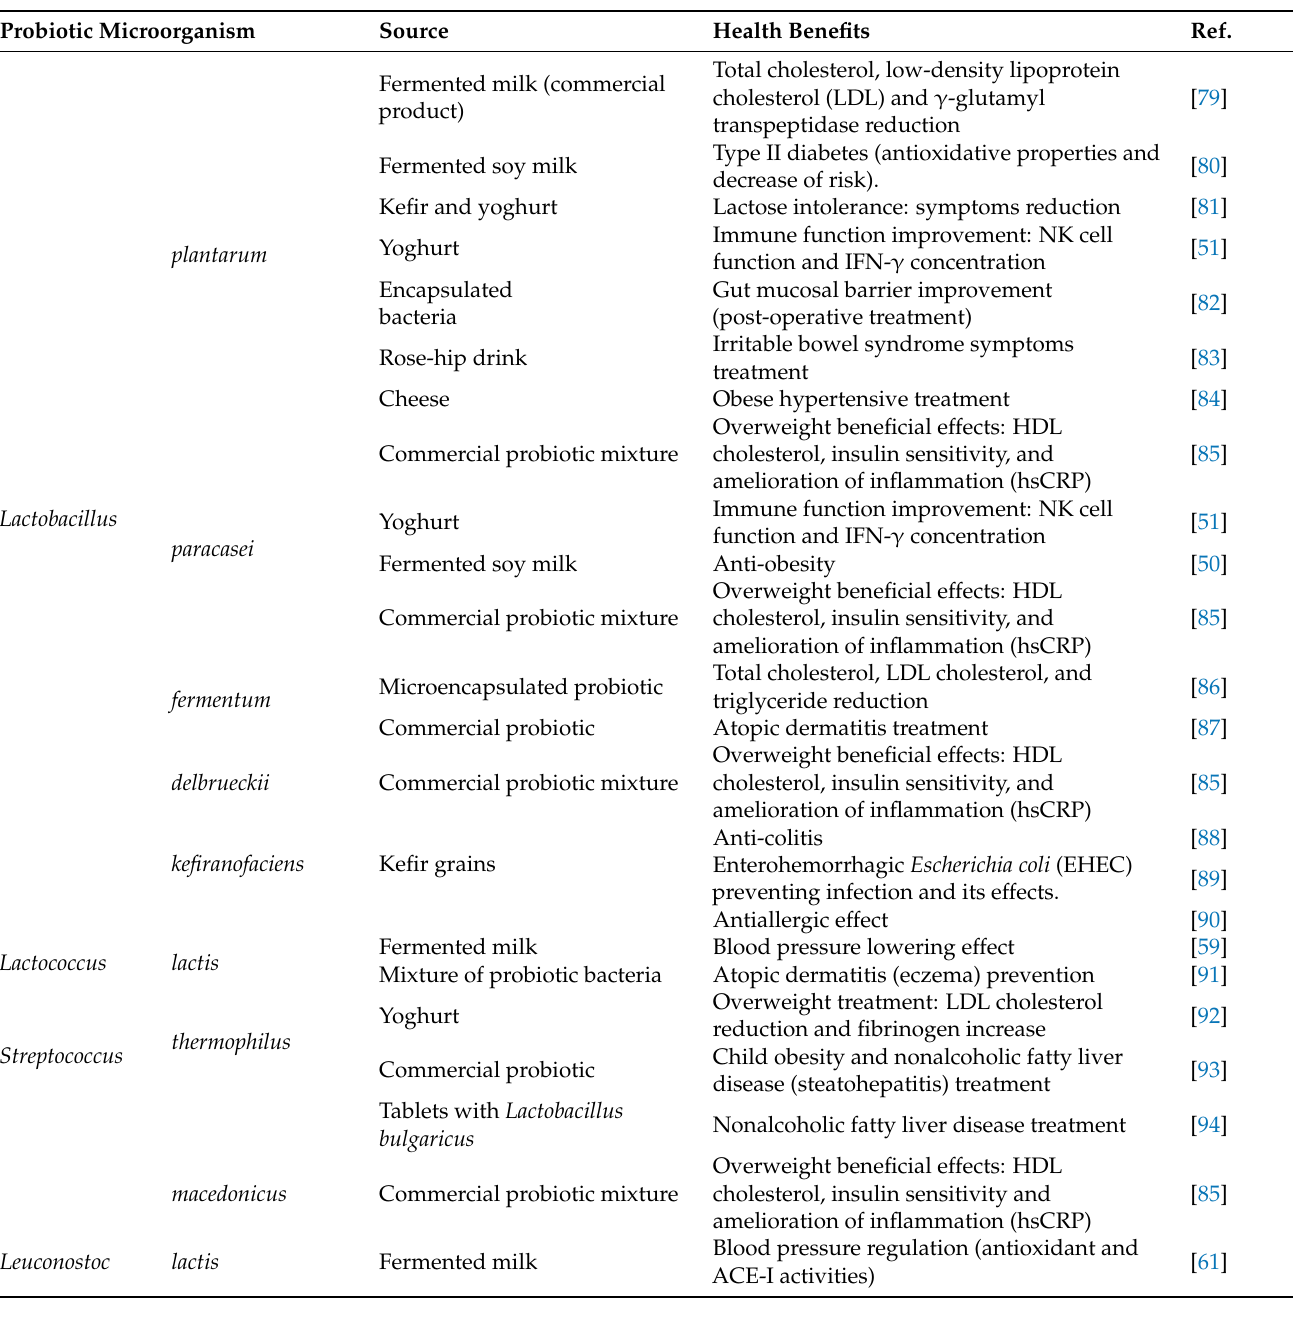
Table 4. Potential human health benefits from probiotics microorganisms isolated from raw buffalo ( Bubalus bubalis ) milk on functional